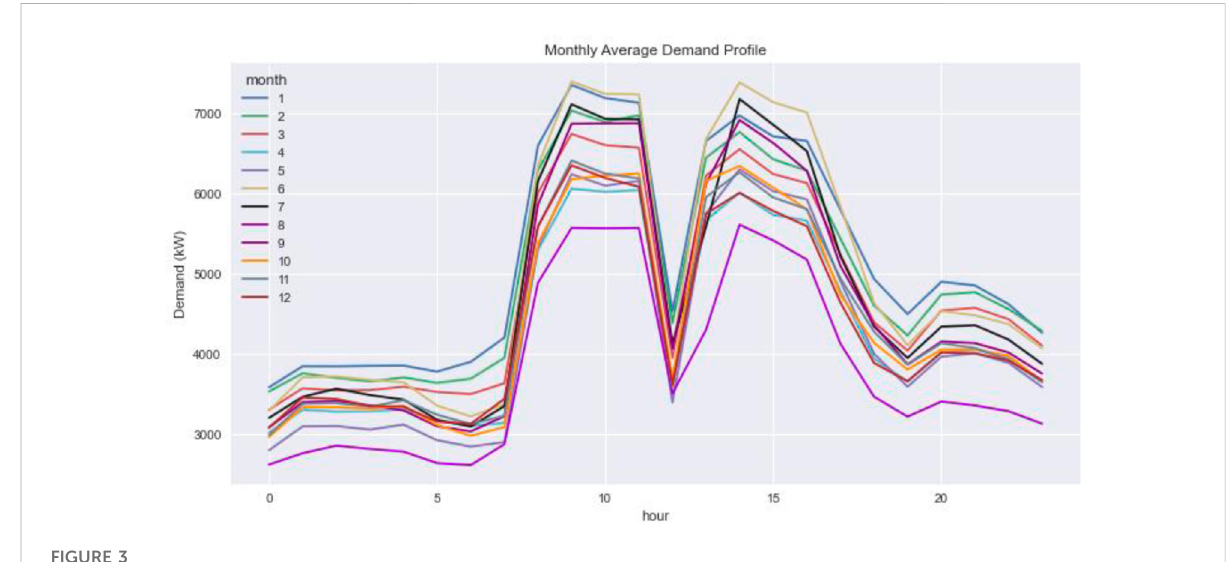
FIGURE 3 Monthly average industrial demand pro fi le.